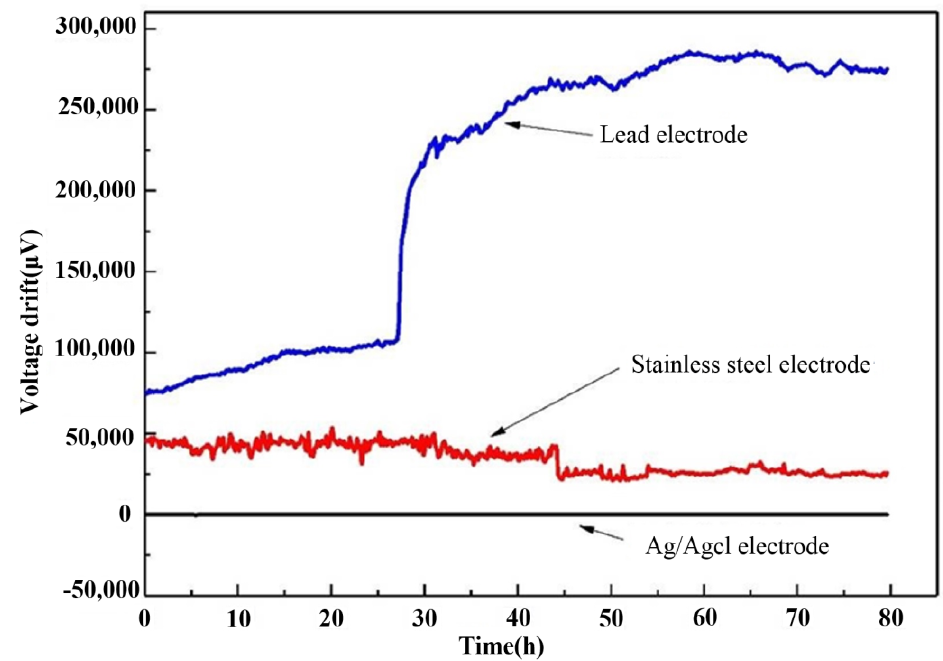
Figure 5. Test curves of the drift of voltage difference between two electrodes with different materials in the absence of any current injection.